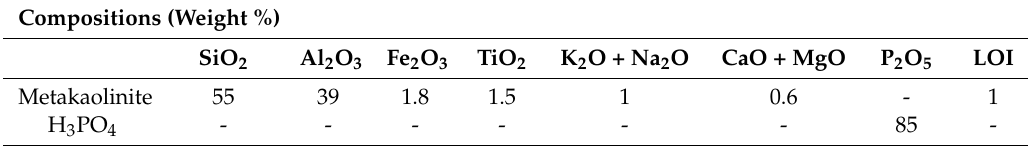
Table 1. Chemical composition of metakaolinite and phosphoric acid in